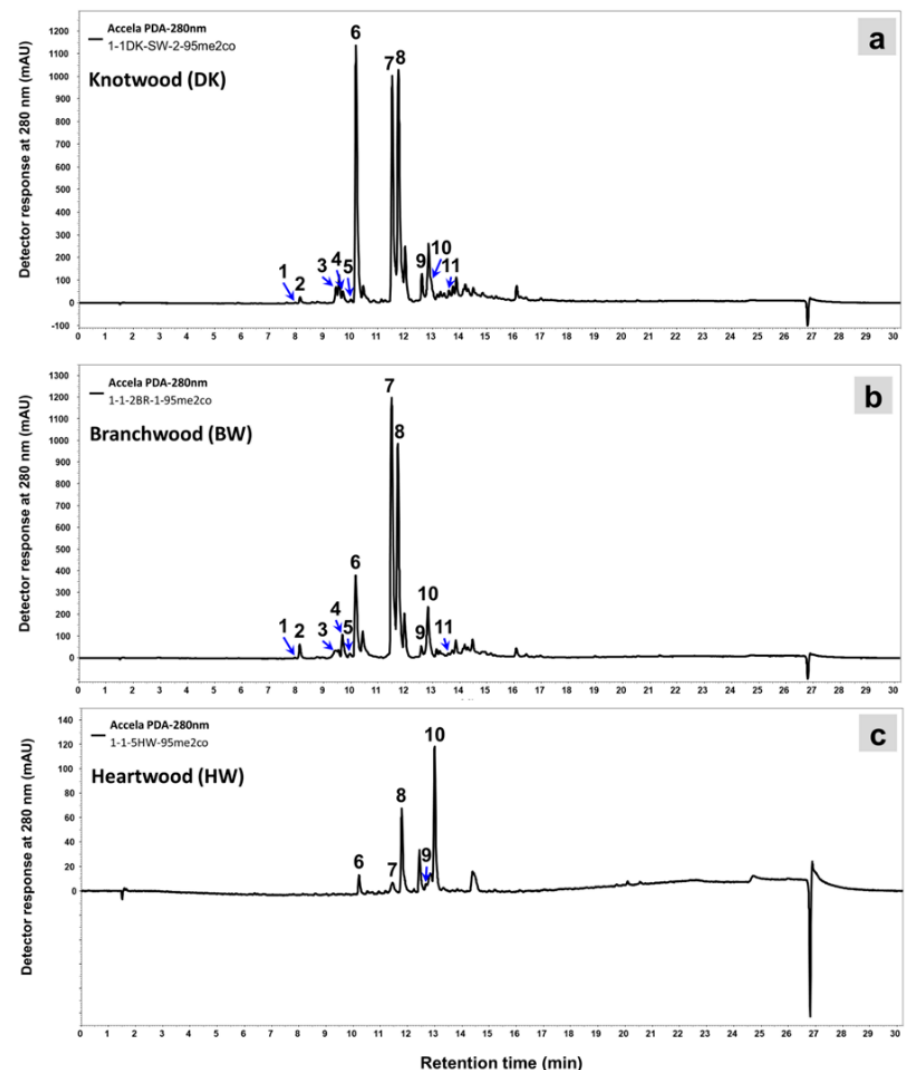
Figure 5. HPLC–PDA chromatograms of acetone extracts of silver fir ( A. alba ) measured at 280 nm. ( a ) Wood of a dead knot taken from the sapwood (DK–SW). ( b ) Wood of a branch. The sample was taken at a distance of 10 cm from the stem (BW10). ( c ) The oldest, innermost part of heartwood (HW5) (Figure 1). For the identity of the chromatographic peaks, see Table 3. As with the extracts of KW, the highest peaks on the HPLC chromatogram for BW were represented by lignans (Figure 5b). There is an obvious difference between the chromatograms in Figure 5 in the heights of the peaks, especially those representing lignans (peaks nos. 6, 7, 8, 9, and 10). The content of lignans in the acetone extracts of DK-SW (Figure 5a) was much higher than in BW (Figure 5b) and HW (Figure 5c). The